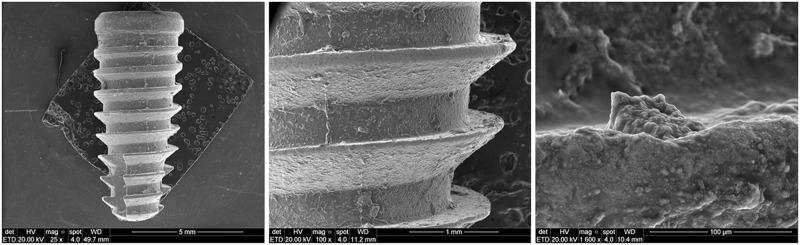
In (a) an image of low magnification of the implant showing the bone tissue deposition over the entire surface. In (b) an image with more increase showing the presence of bone tissue deposited on the implant surface with a uniform and consistent thick layer. In (c) an image with great increase showing that the bone tissue deposition with a more consistent layer.